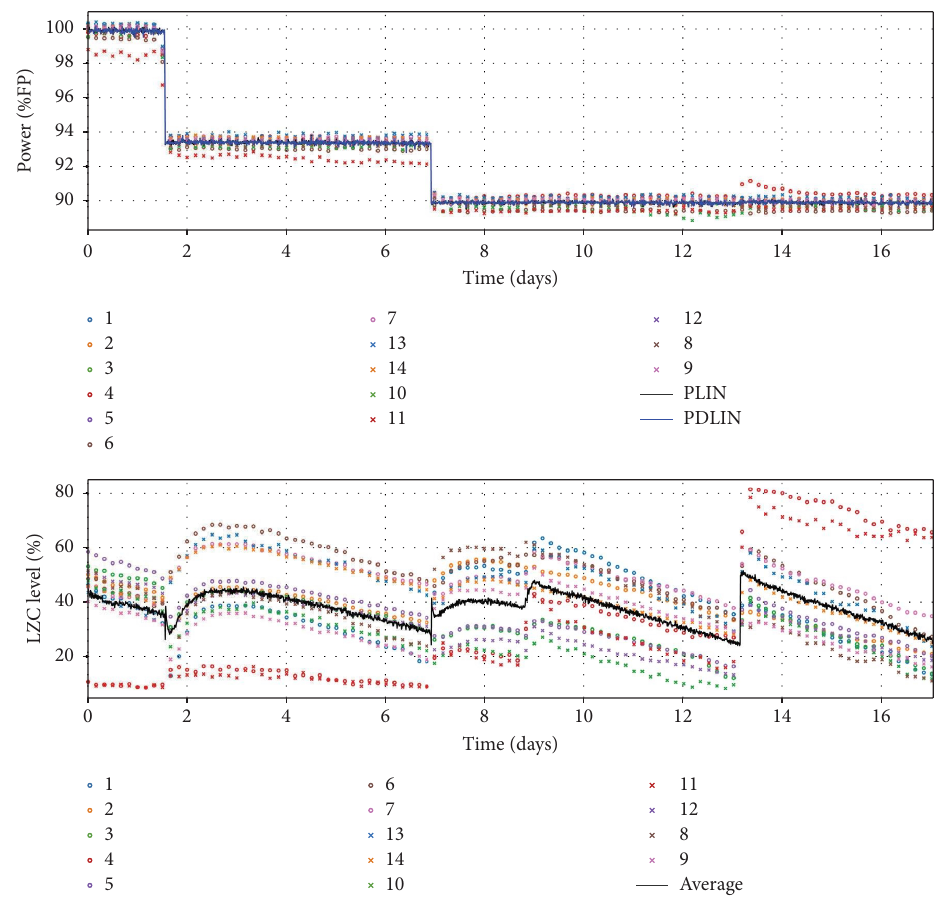
Figure 4: Reactor power and liquid zone level trends for CANDU 900 shim operation. Day 0 in this fgure corresponds to the start of day 12 in the event